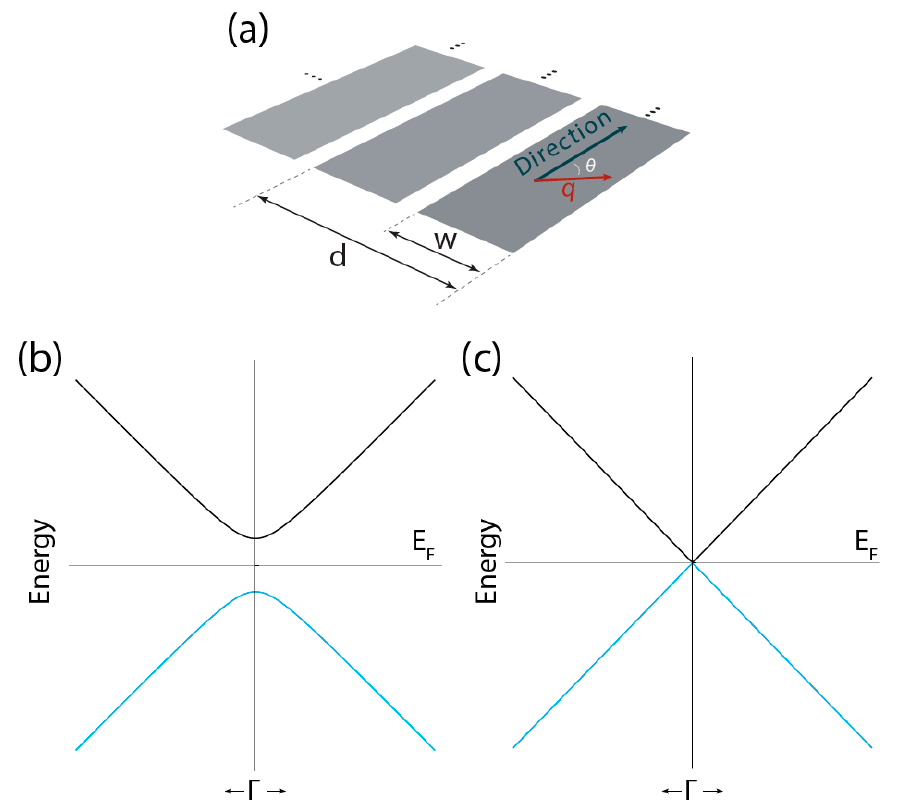
Figure 1. Schematic representations: ( a ) freestanding 2D GNR array; ( b , c ) the band dispersion around the Γ point ( 𝑘 → 0 ) of a hypothetical ultra-narrow and wide GNR, respectively, for n = 1 The ribbon width is denoted as 𝑤 , the vacuum distance between contiguous ribbons is denoted as 𝑑 − 𝑤 , q is the wave vector along the GNR direction, and 𝜃 is the angle for different orientations of the plasmon momentum.